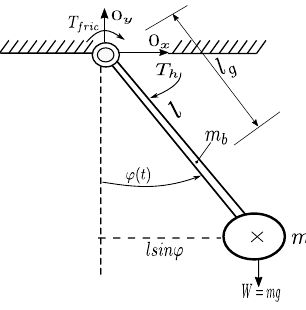
Figure 4. The pendulum free body